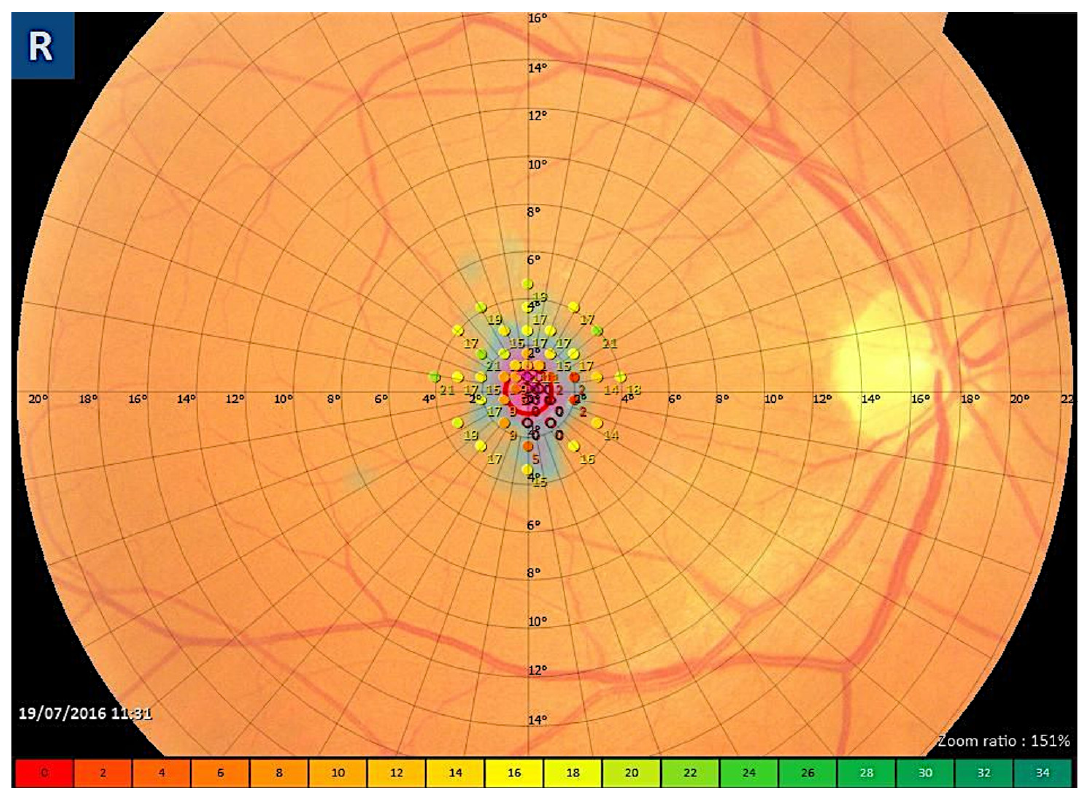
Figure 6. Microperimetric sensivity map in a case of full-thickness macular hole: an absolute central scotoma is evident with a surrounding ring of relative scotoma.